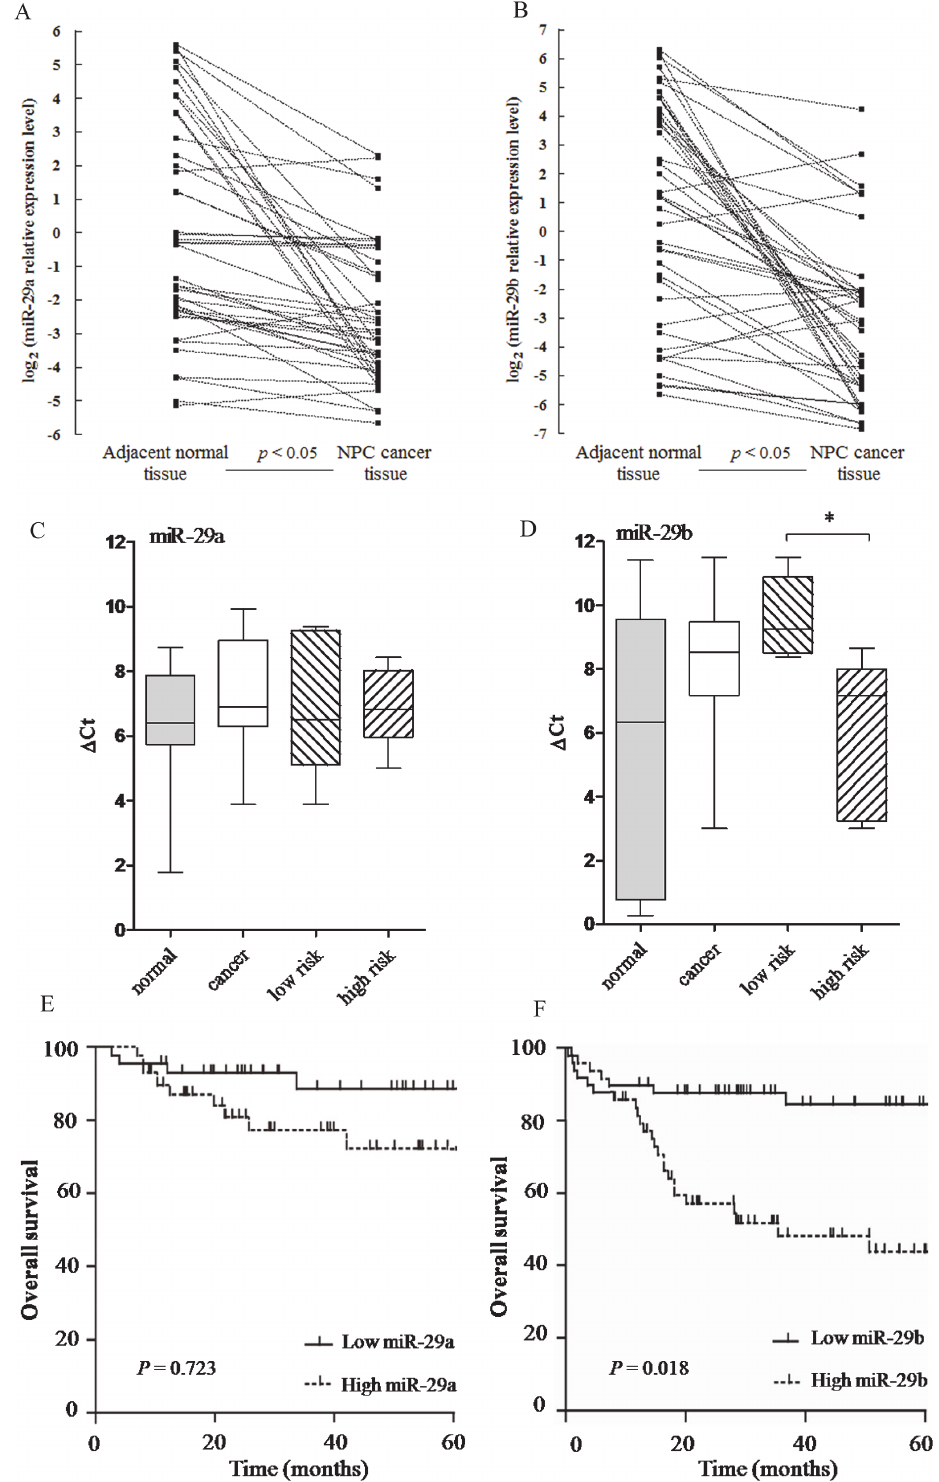
Fig 7. miR-29b is associated with specific risk groups and NPC patient survival. (A, B) Comparison of the miR-29a/b abundance in paired NPC tumors (42 NPC patients) and adjacent normal tissues (42 normal controls). The solid squares represent the relative expression level of miR-29a/b. The miR-29a/b